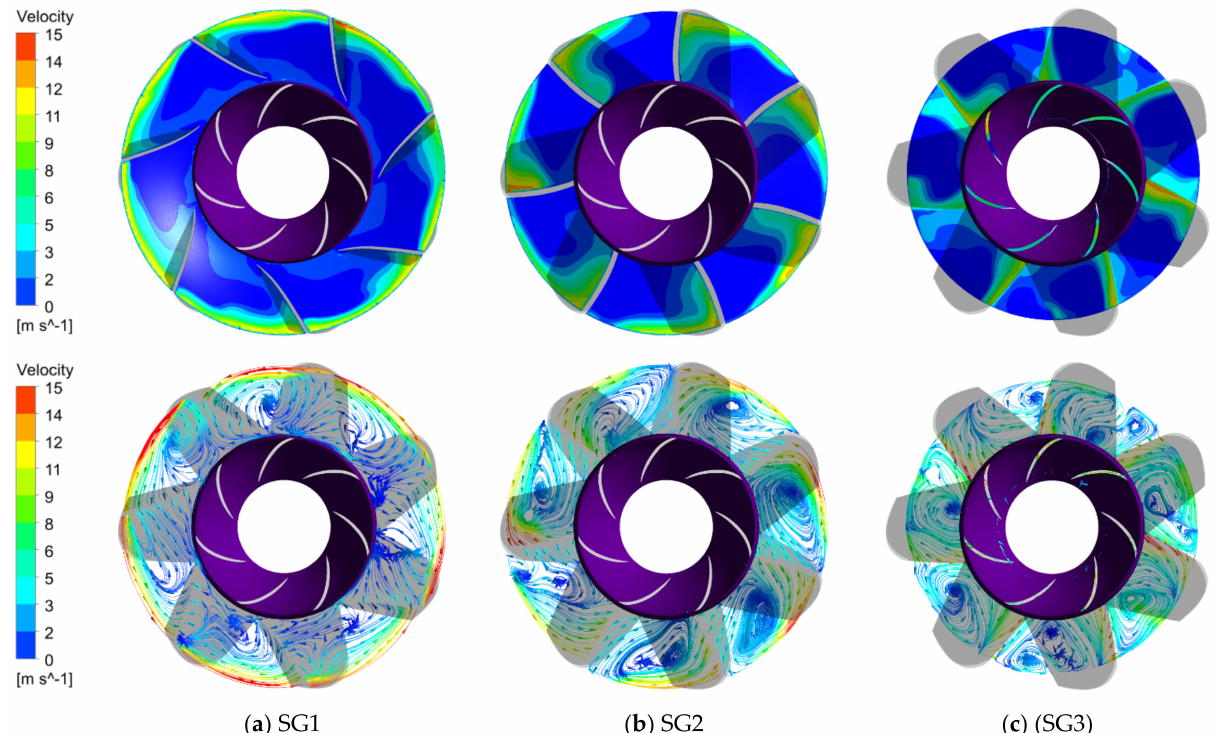
Figure 12. Flow axial velocity contours and streamlines within the diffuser under 0.41 Q BEP flow conditions for different positions along the streamwise direction.